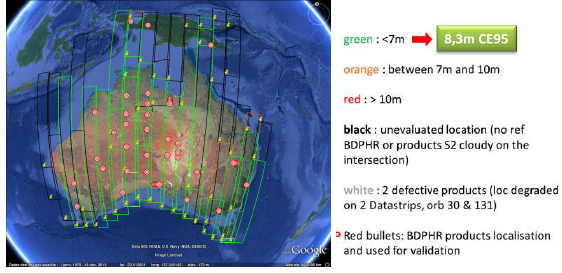
Figure 9. Austrialia GRI mean geolocation performance.